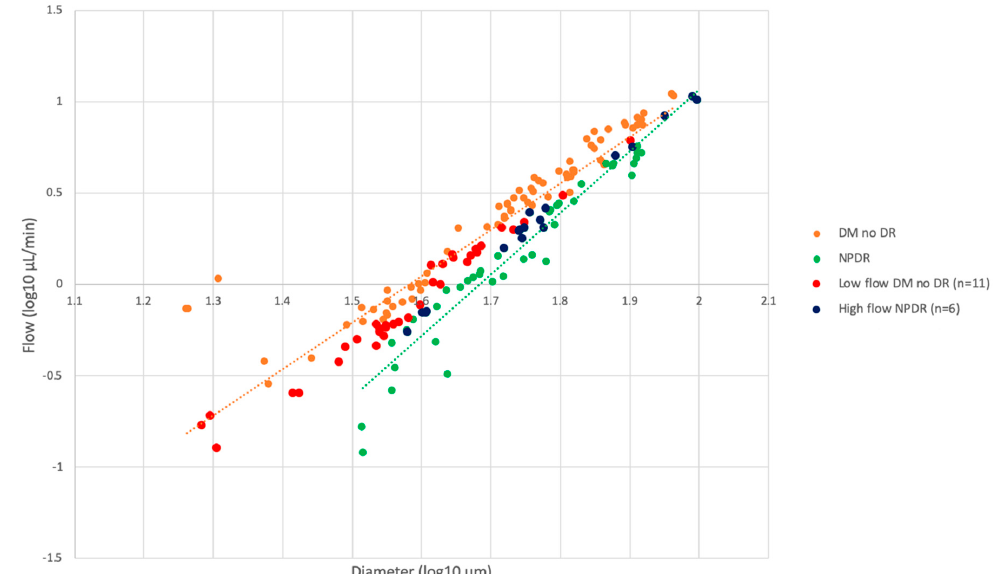
Figure 4. Log–log scale comparison of blood flow and diameter with OCT vessel density, comparing diabetes without retinopathy and non-proliferative diabetic retinopathy. Graph highlighting the distribution of the “high” and “low-flow” outliers as described in the text. Abbreviations: DM no DR = diabetes mellitus with no diabetic retinopathy, NPDR = non-proliferative diabetic retinopathy.